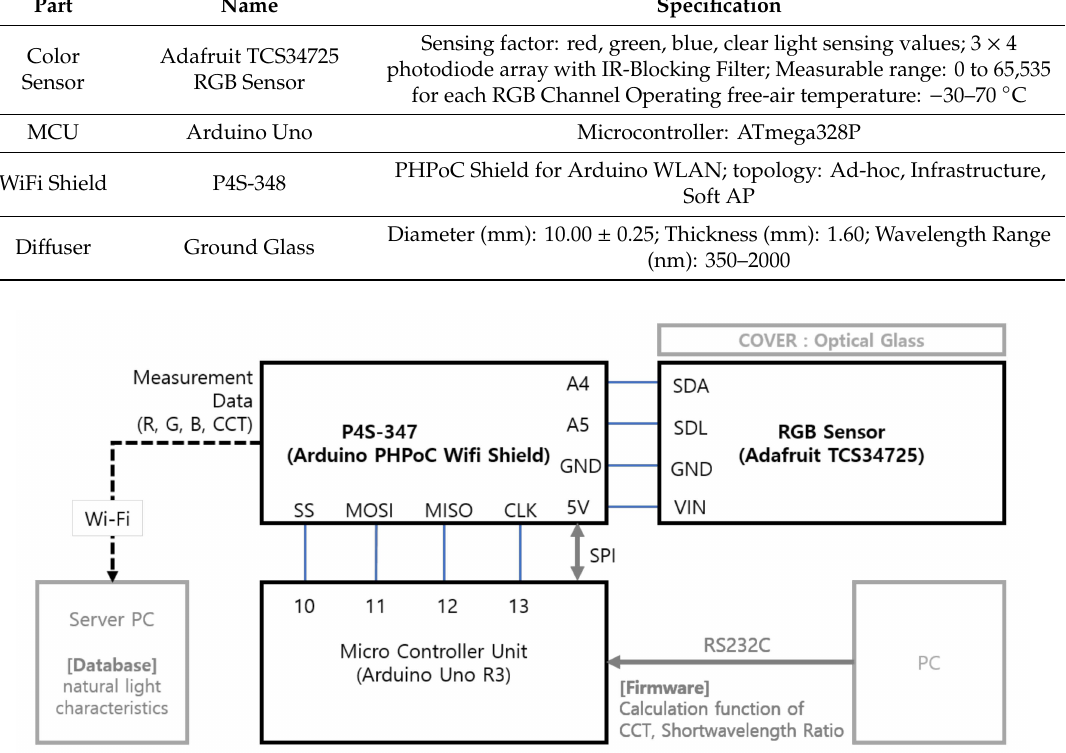
Table 4. Main specifications of RGB-sensing device.